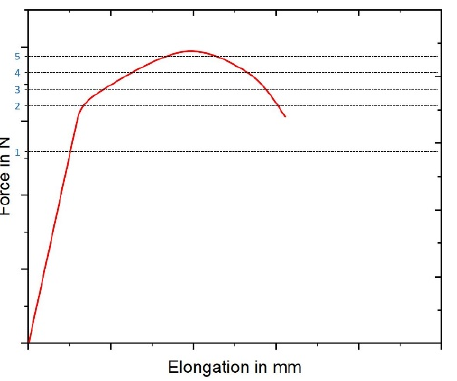
Figure 6. Schematic force/elongation diagram with required scans (vertical lines numbered from 1–5) next to the initial scan.